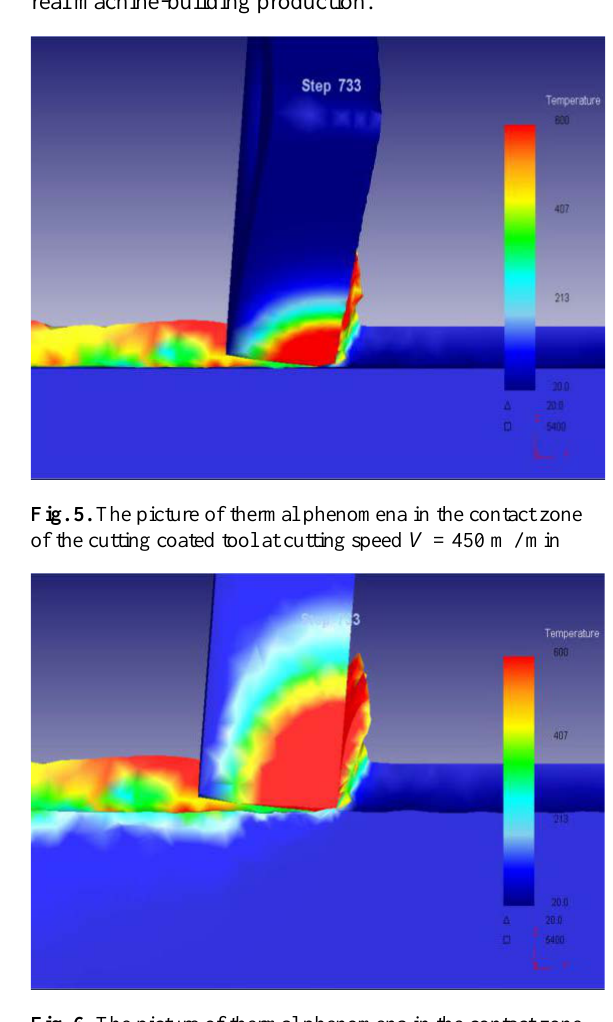
Fig. 6. The picture of thermal phenomena in the contact zone of the cutting uncoated tool at cutting speed V = 450 m / min